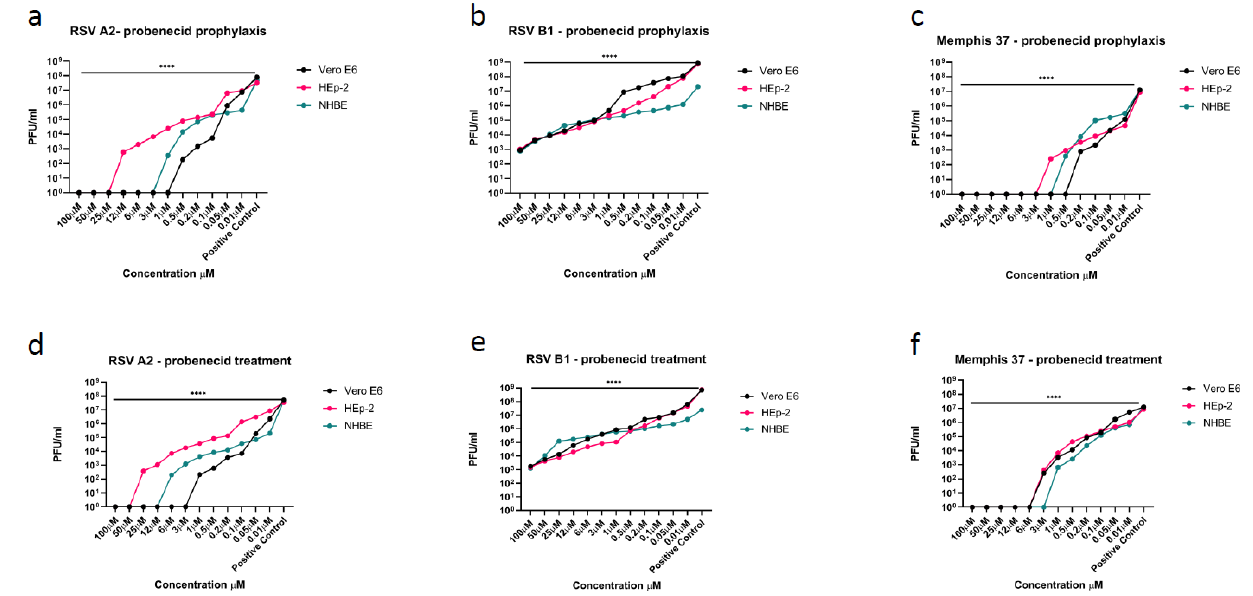
Figure 1. ( a – c ), Cell lines were prophylactically treated with probenecid 24 h prior to infection of RSV A2, RSV B1, or Memphis-37. Probenecid prophylaxis significantly (**** p < 0.0001) inhibited the virus replication in Vero E6 cells, HEp-2 cells, and NHBE cells compared to control (DMSO only). Viral titers were determined by plaque assay which has a limit of detection of 1 × 10² PFU/mL. The IC 50 and IC 90 values are shown in Table 1. ( d – f ), Cell lines were treated with probenecid 24h after infection of RSV A2, RSV B1, or Memphis-37. Treatment significantly (**** p < 0.0001) inhibited the virus replication in Vero E6 cells, HEp-2 cells, and NHBE cells compared to control (DMSO only). Viral titers were determined by plaque assay. The IC 50 and IC 90 values are shown in Table 1. For RSV B1 the IC 90 values are not available as the virus was not reduced by 90%. Table 1. IC 50 /IC 90 values.